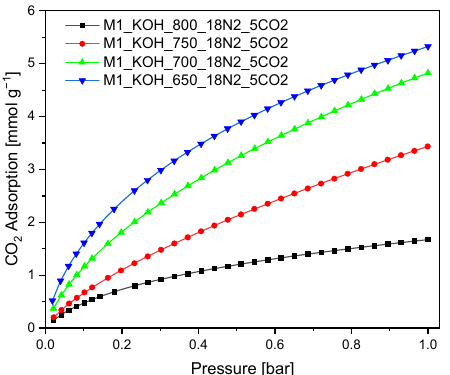
Figure 4. CO 2 adsorption isotherms measured at 0 °C. The symbols express empirical results, lines were obtained based on the Radke-Prausnitz model (a function was chosen on the basis of the lowest value of SNE which the best characterizes experimental values).